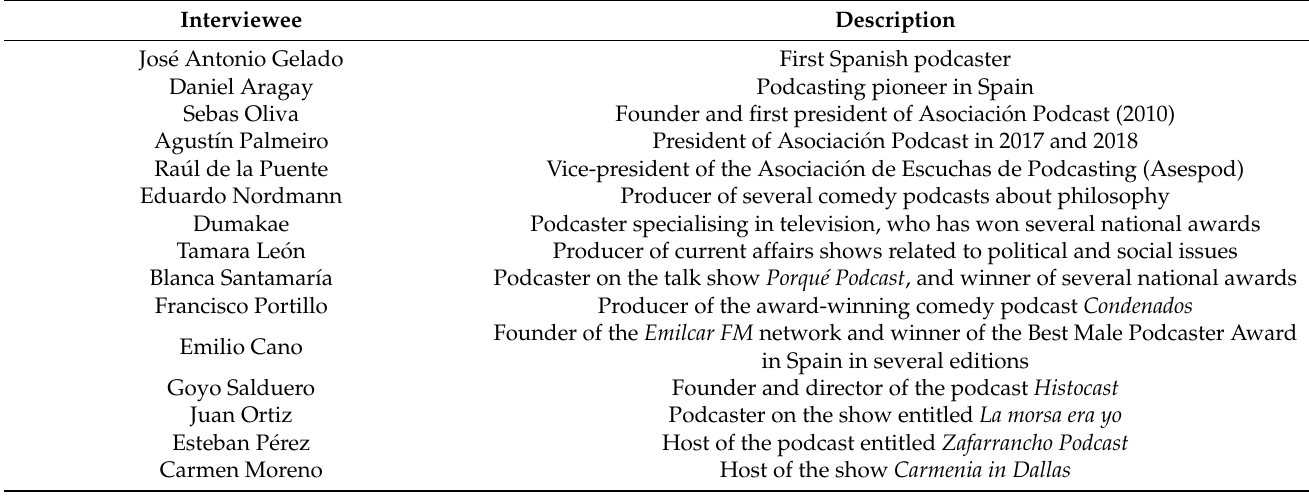
Table 1. Participants in the in-depth